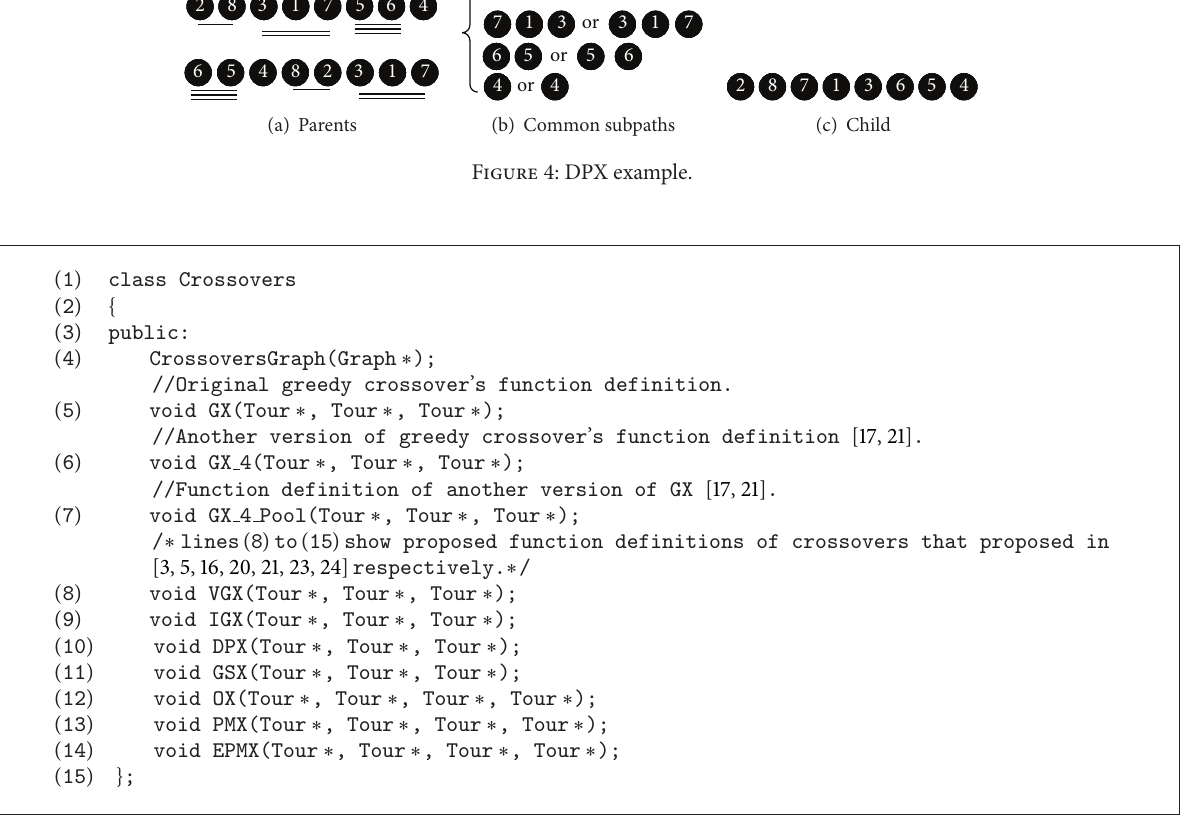
Algorithm 6: Crossovers class ADT.